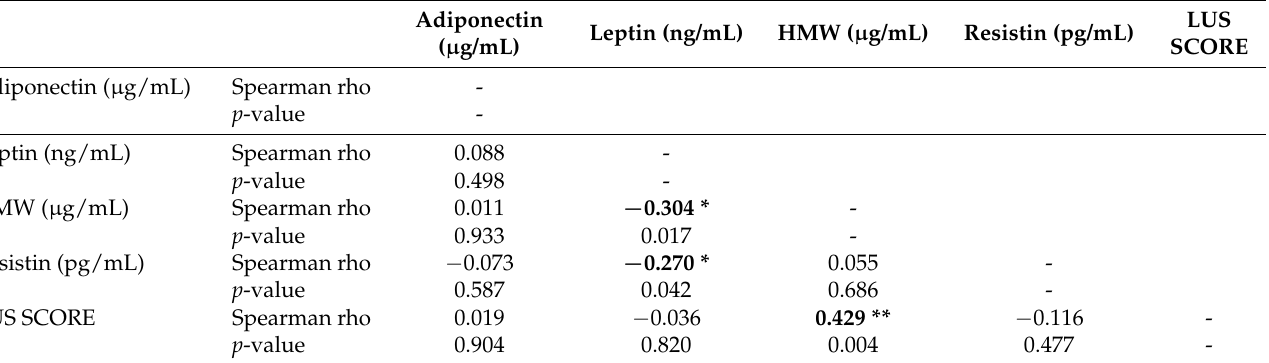
Table 2. Correlation analysis between the adipokines and the LUS score.